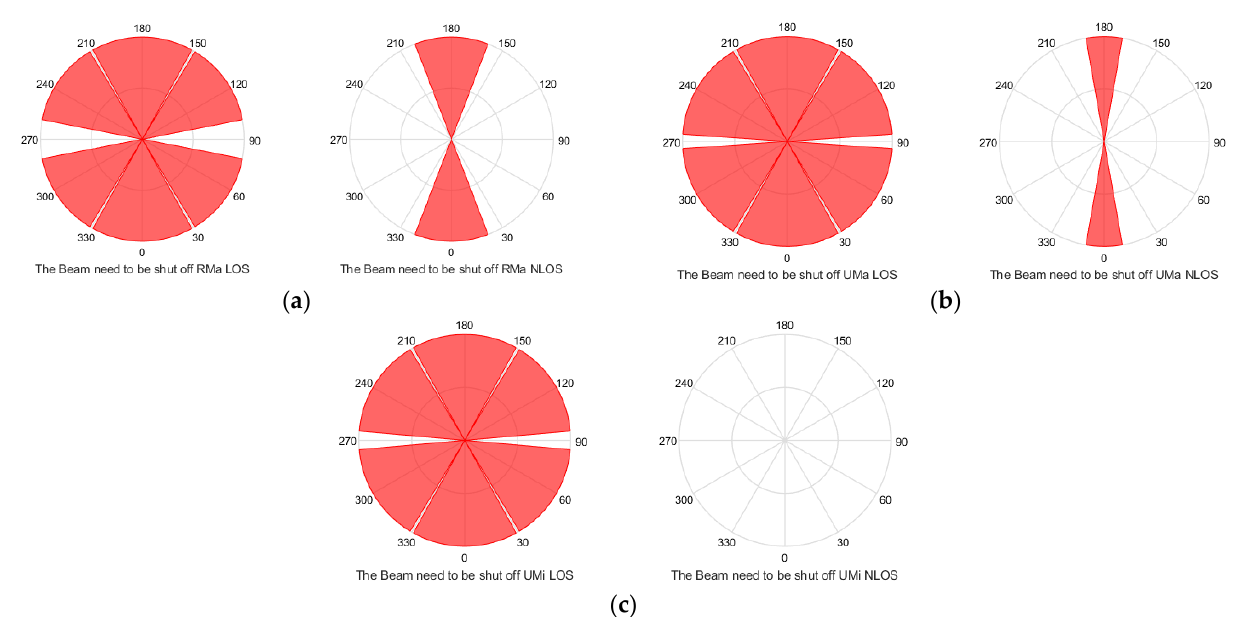
Figure 5. Beam angles that should be shut off: RMa ( a ), UMa ( b ) and UMi ( c ) LOS and NLOS.